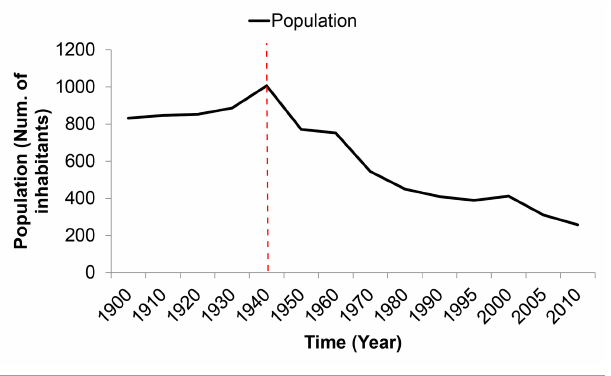
Fig. 4 . The oasis of Comondú population (1900–2010). The red dashed line indicates the turning point. Source: population and housing censuses of the Mexican National Institute of Statistics and Geography (INEGI